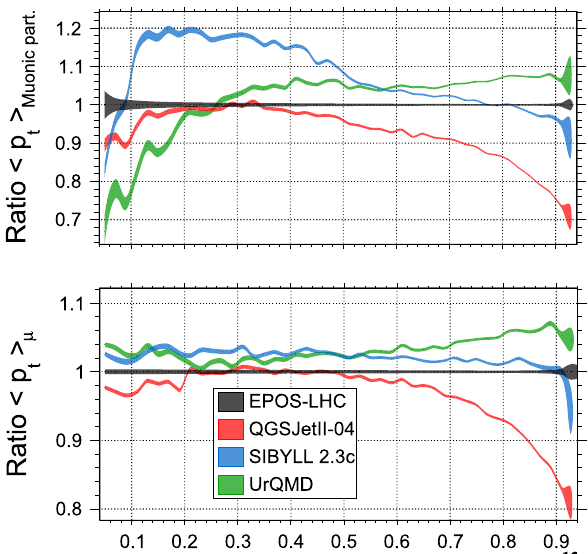
Fig. 7 Ratios with respect to EPOS-LHC of the (top panel) first inter- actionmuonicfamilyparticles(energyabove5GeV)and(bottompanel) ground level muons average transverse momenta as a function of the first interaction